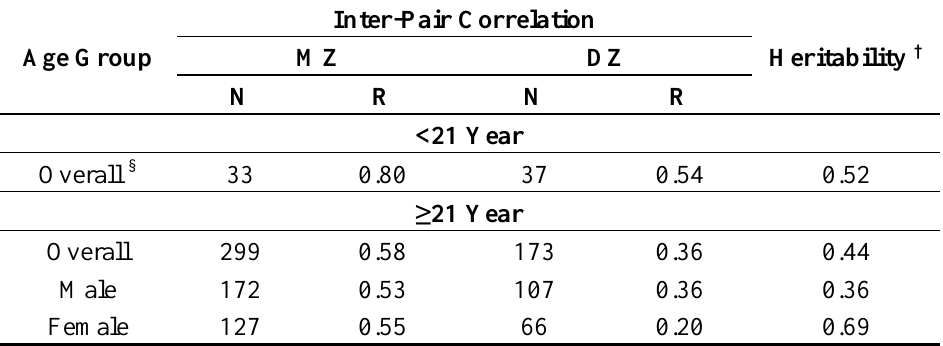
Table 3. Heritability of homocysteine by gender and age group. MZ, monozygotic; DZ, dizygotic. Age Group